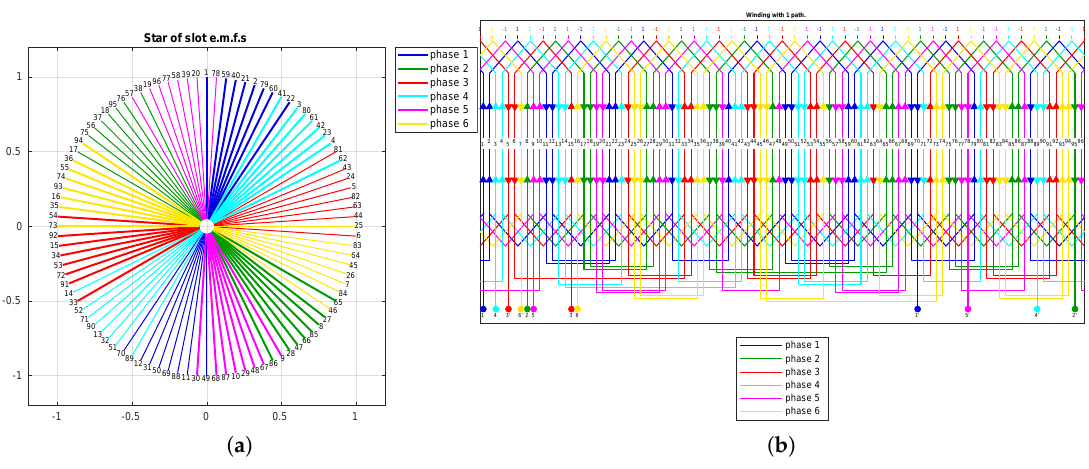
Figure 18. ( a ) Star of slots of a 6-phase reduced single-layer winding with N = 96, p = 5 and ( b ) related winding scheme with 1-st order double sided